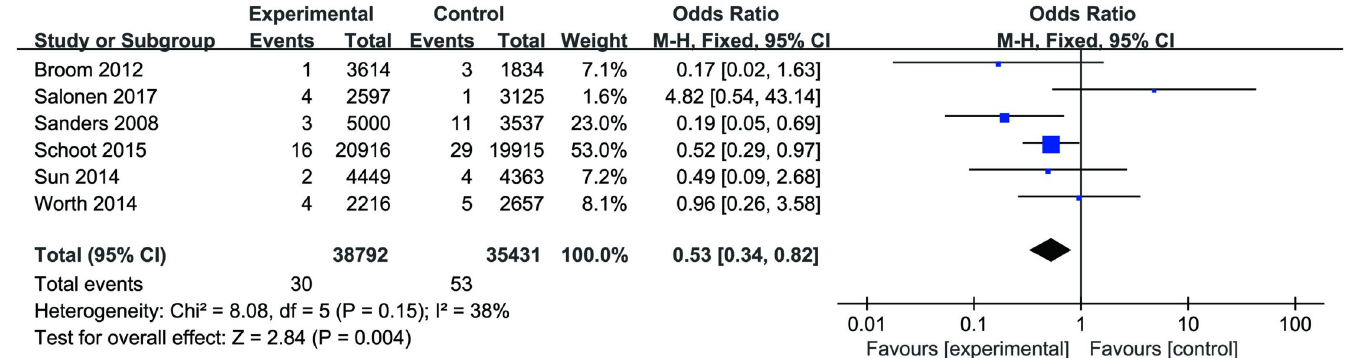
studies ( P = 0.34, I 2 = 8%). No significant difference was observed between the groups (OR = 0.73, 95% CI 0.33, 1.62, P = 0.43) (S2 Fig). Catheter removal. Two studies[16,22] involving 371 patients with 371 catheters were entered into the analysis of the effects of intervention on catheter removal. The fixed-effects model was used because the heterogeneity test showed an I 2 of 0% among studies. No signifi- cant difference was observed between the groups (OR = 0.70, 95% CI 0.38, 1.28, P = 0.25) (S3 Fig). Thrombosis. Four studies[16,18,21,22] involving 505 patients with 505 catheters contrib- uted to the analysis of thrombosis. There was no heterogeneity among the trials ( P = 0.48, I 2 = 0%); therefore, we used the fixed-effects model for the pooled estimate. The pooled data showed that the occurrence of thrombosis was not significantly different between the groups (OR 0.96, 95% CI 0.21, 4.42, P = 0.96) (S4 Fig). Mortality. Four studies[16,20,22,24] involving 441 patients reported mortality. A fixed- effects model was applied because no statistical heterogeneity was indicated ( P = 0.92, I 2 = 0%). The results of the meta-analysis showed that there was no significant difference between ethanol and heparin (OR 0.58, 95% CI 0.16, 2.02, P = 0.39) (S5 Fig).